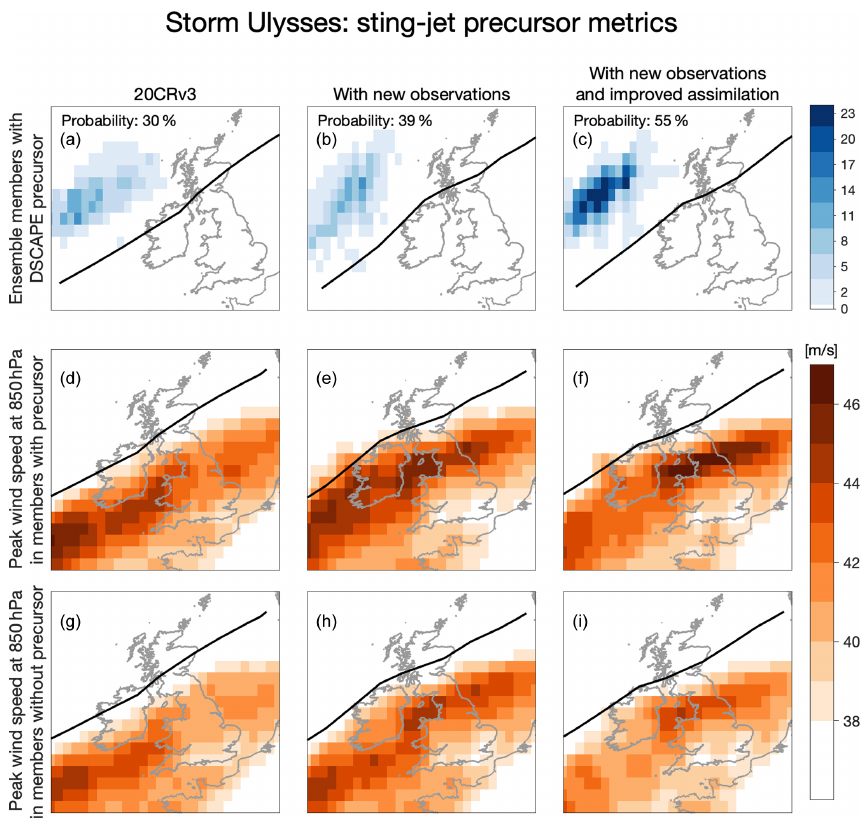
Figure 6. DSCAPE metric during Storm Ulysses, showing the number of ensemble members with a sting-jet precursor at that location at any point during the storm (a–c) . The number of members (out of 80) increases as the reanalysis is improved, and the probability values signify the fraction of ensemble members with at least one grid point where the precursor is present at any time during the storm. The bottom two rows (d–i) show the maximum wind speed at 850hPa in two sub-ensembles, using members with (d–f) and without (g–i) a sting-jet precursor. Peak winds > 45ms − 1 (100mph) are seen in the improved reanalysis at locations where known significant damage occurred over land, but only in the members with a precursor. The track of the minimum sea level pressure is shown by the black line in each panel, which varies slightly between